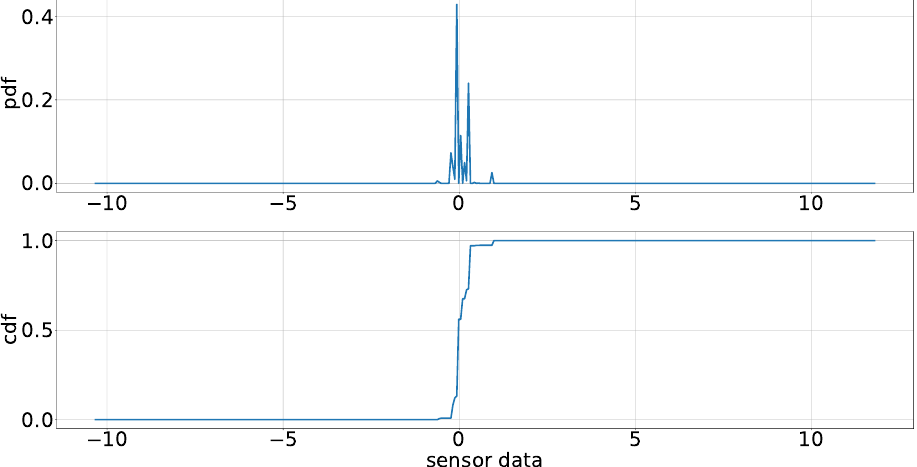
Figure 17. One-dimensional distribution functions of the inertia model for (cid:101) R for a value of 0.1